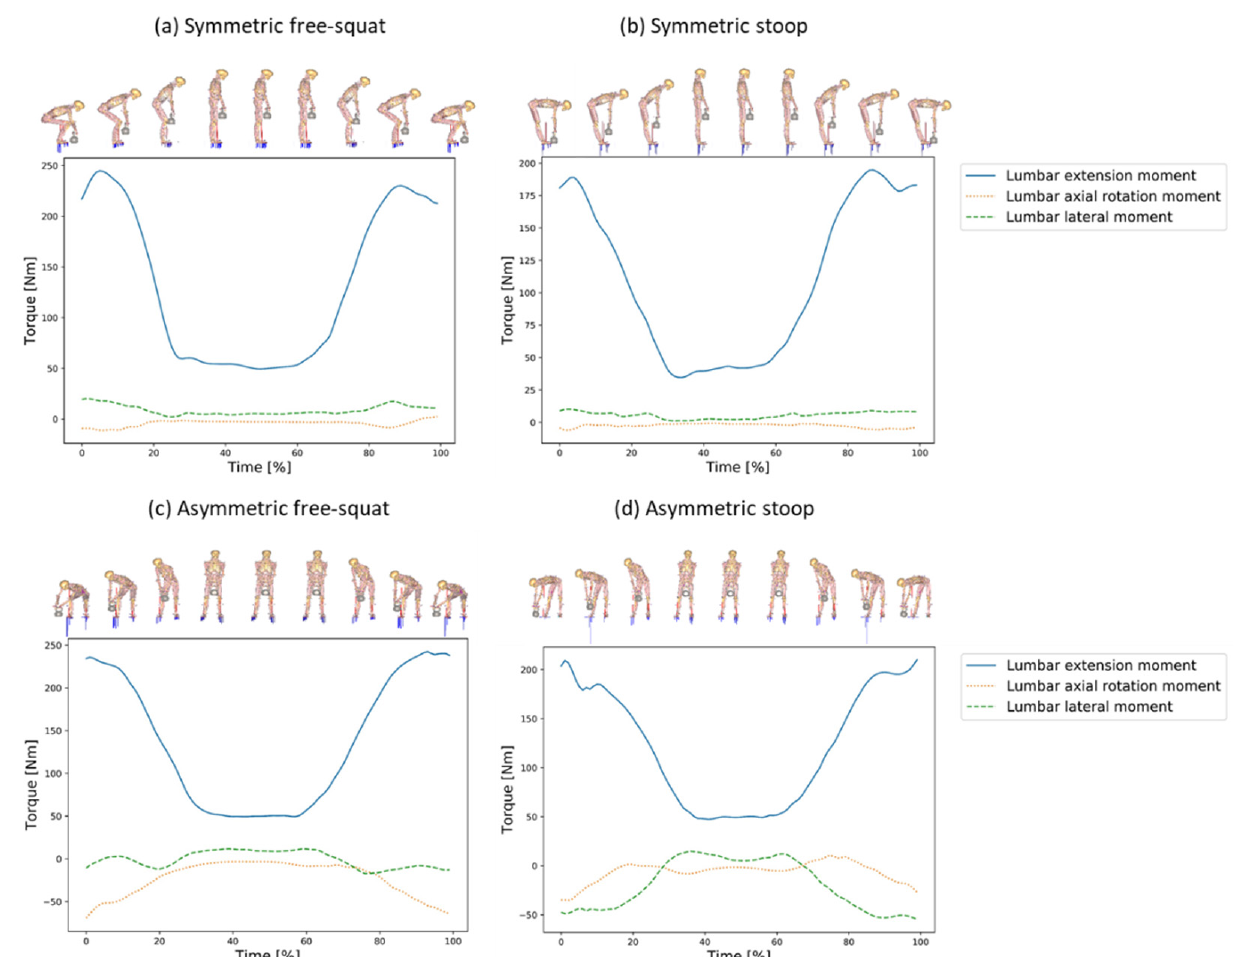
Figure 5. Lumbar joint moments for all motion techniques and external weight of 20 kg illustrated together with the human model in sagittal ( a , b ) and frontal ( c , d ) plane as mean moments for all five trials over normalized time.